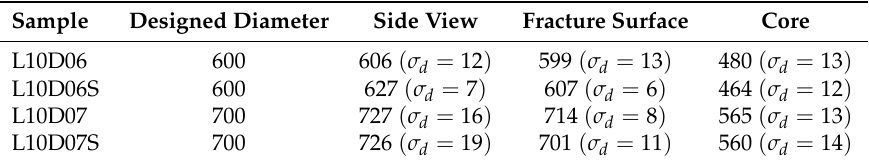
Table 2. Mean values of the measured diameters ( d ) of the test samples in µm.